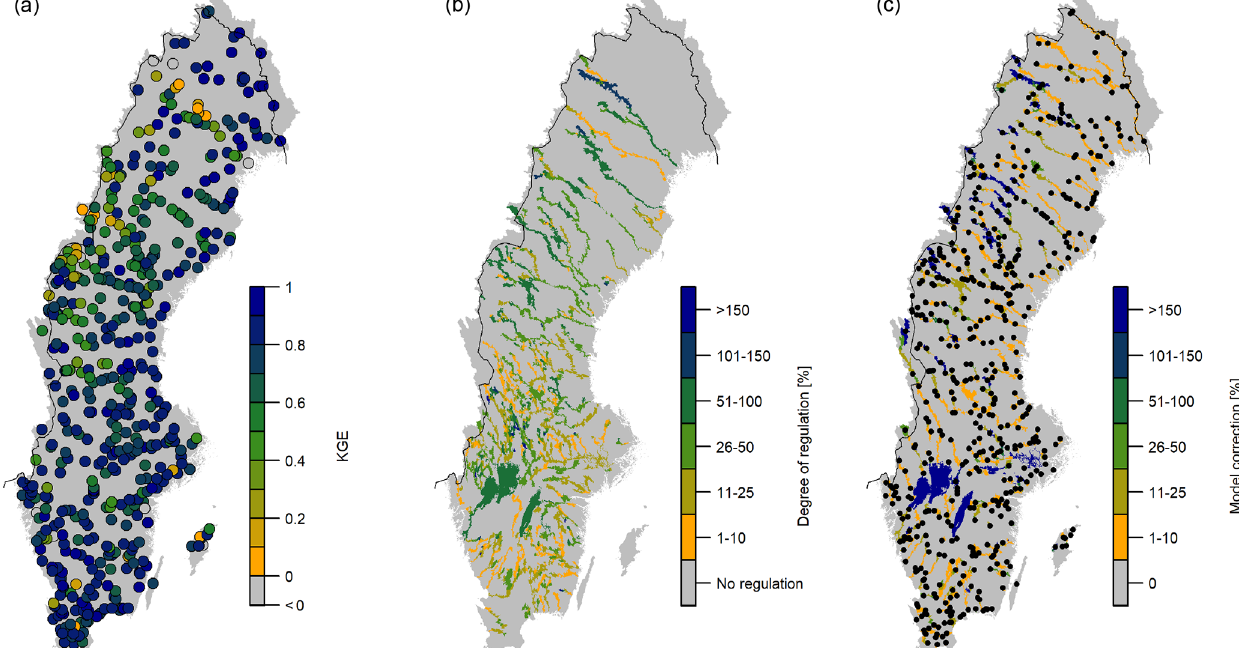
Figure 1. Study domain: (a) S-HYPE model Kling–Gupta efficiency (KGE) for the period 1981–2016 for each of the 539 hydrological stations, (b) degree of regulation of each S-HYPE catchment, and (c) average model correction value for each S-HYPE catchment following the autoregressive correction